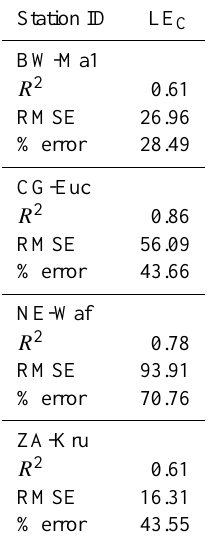
Table 7. The slope ( B 1 ) and intercept ( B 0 ) of a linear fit of modeled LE using the mean for all input data and 10000 perturbations of one test input variable ( i ) versus the test input variable in standard space.